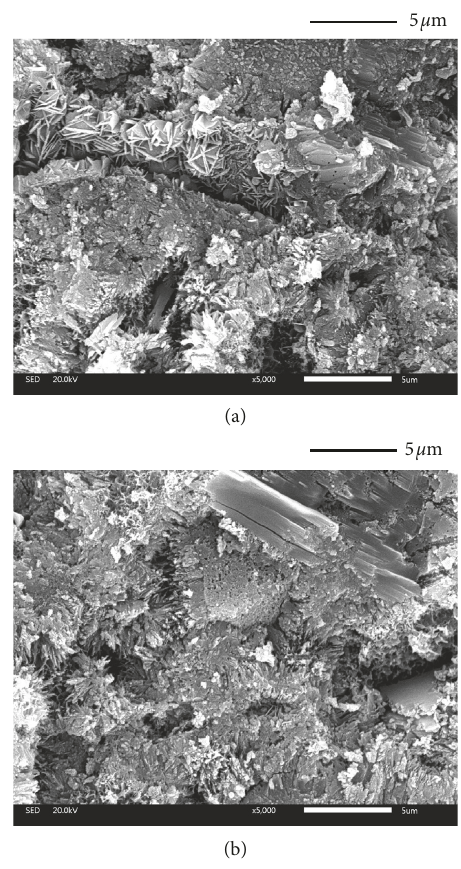
Figure 6: Typical SEM images of specimens hydrated for